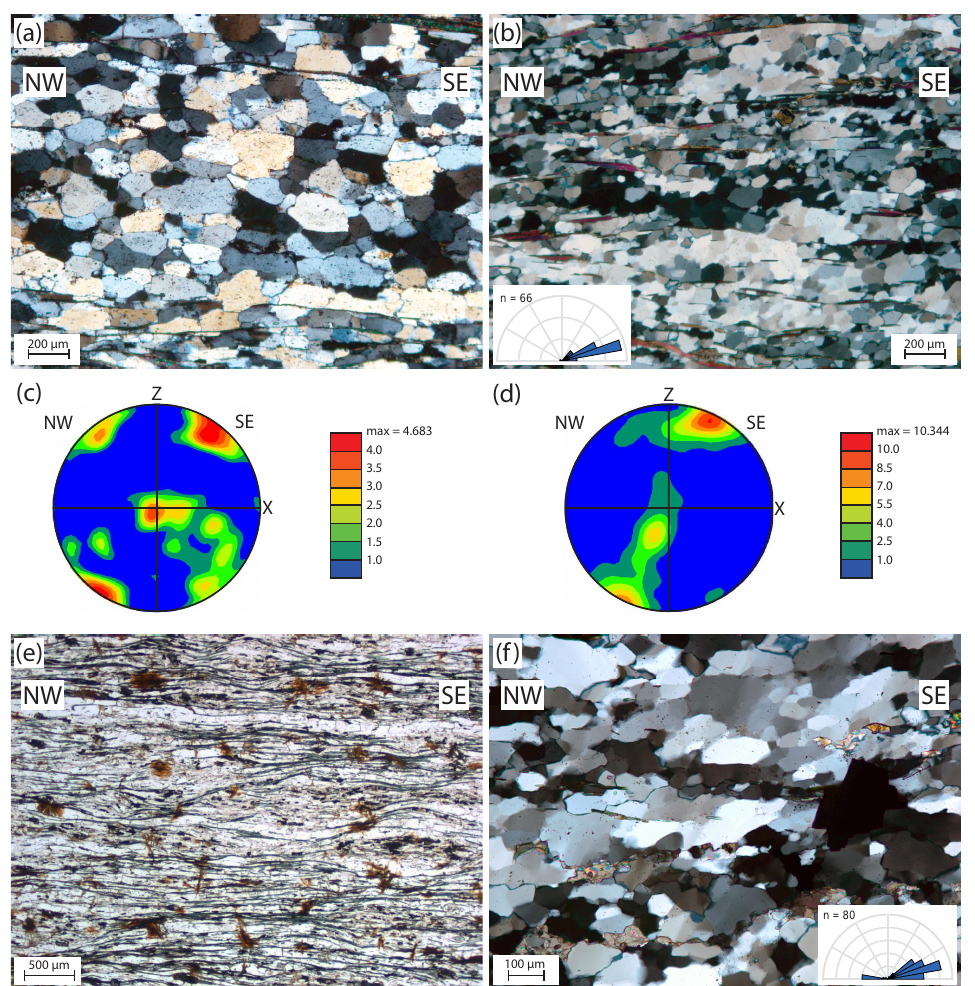
Figure 6. (a) Metachert from Prairie Fork (Sample PS186) and (c) its quartz CPO. The sense of shear cannot be inferred from panel (a) due to the lack of indicators. The quartz c axis pole figure in panel (d) shows a symmetrical skeleton, but there are variations in density suggestive of top-to-SE sense of shear. (b) Metachert from Iron Fork (Sample PS103) and (d) its quartz CPO. The diagram in panel (b) illustrates the shape orientation of recrystallized quartz grains; quartz grains pinned by other minerals were not counted. Both quartz recrystallized grain fabric in panel (b) and quartz c axis pole figure in panel (d) show a top-to-SE sense of shear. Note the grain size difference between panels (a) and (b) . (e) Metachert with greenish needle-shaped amphibole and brown stilpnomelane. Sample PS131 from Fish Fork. Shear bands defined by amphiboles exhibit a top-to-NW sense of shear. (f) Metachert sample (PS100) from Iron Fork. The diagram in panel (f) illustrates the shape orientation of recrystallized quartz grains; quartz grains pinned by other minerals were not counted. The quartz recrystallized grain shape fabric and tilted prismatic subgrain walls indicate that the sense of shear was top-to-SE. Sample locations are available in Fig. 2a and Table